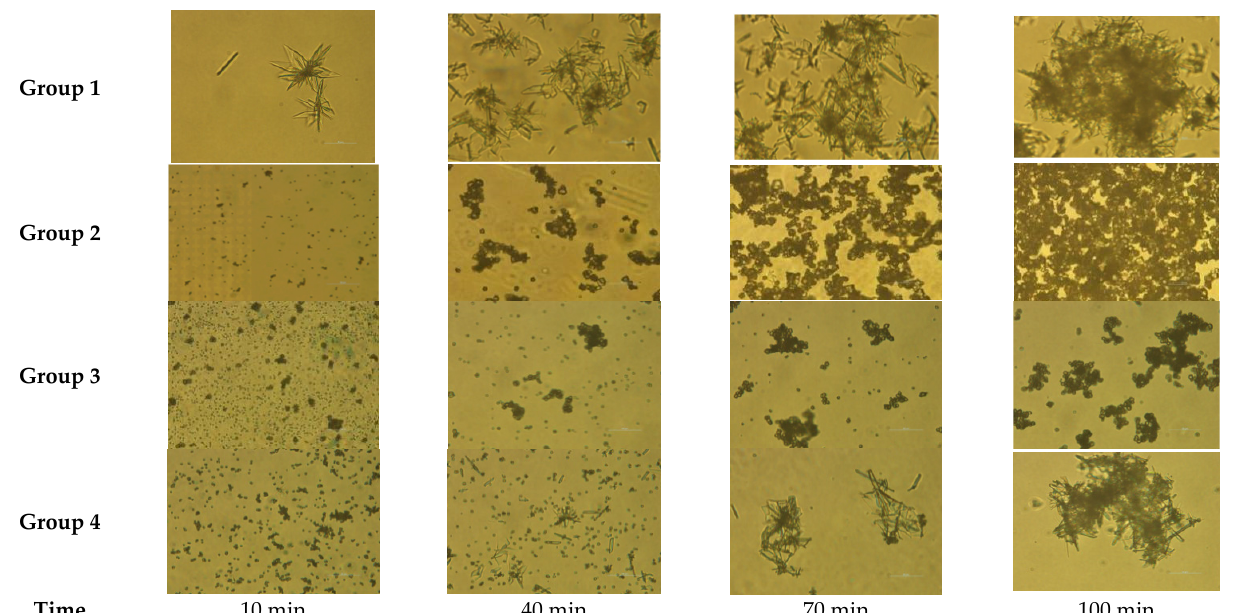
Figure 6. The morphology of scale deposition in each group at 10 min, 40 min, 70 min and 100 min was observed at 40 times, using a constant temperature heating magnetic stirrer for constant temperature and stirring of the solution, set to 35 °C, 250 r/min.